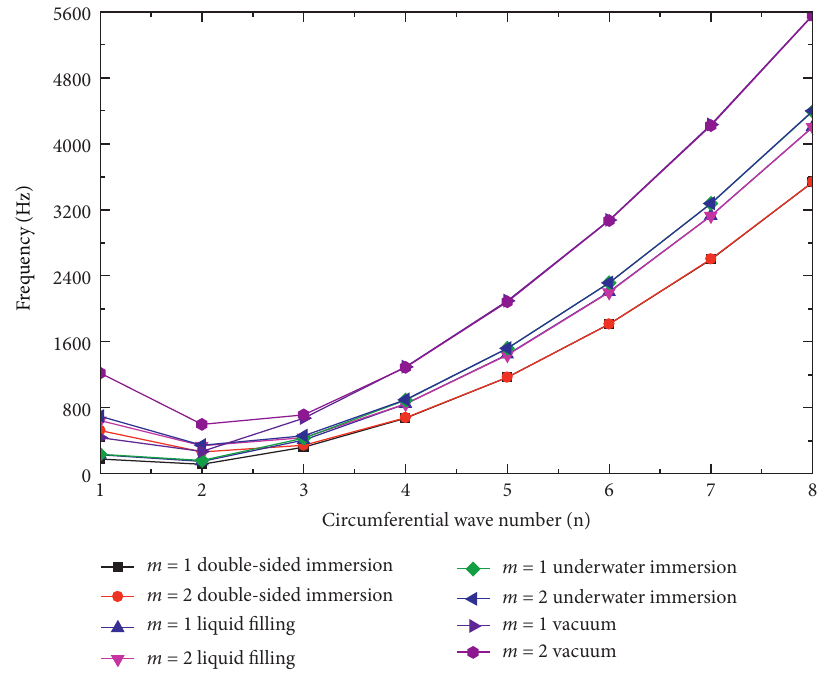
Figure 3: Frequency curves of ring-stiffened cylindrical